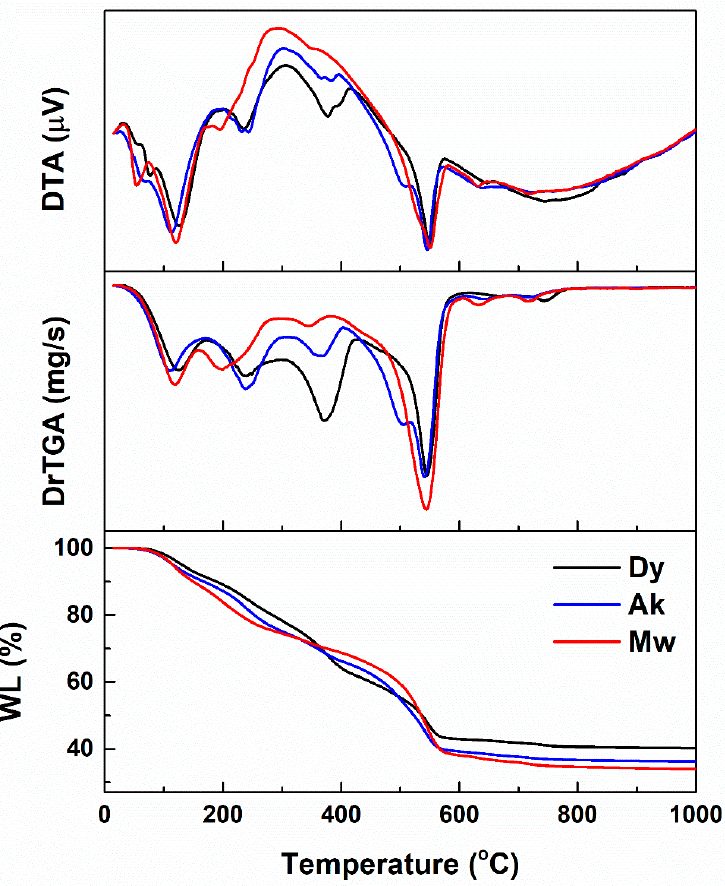
Figure 1. Complex thermal analyses of the dry gels corresponding to: diopside (Dy), akermanite (Ak) and merwinite (Mw) compositions. WL represents weight loss, DrTGA is the derivative thermogravimetric analysis and DTA stands for differential thermal analysis.